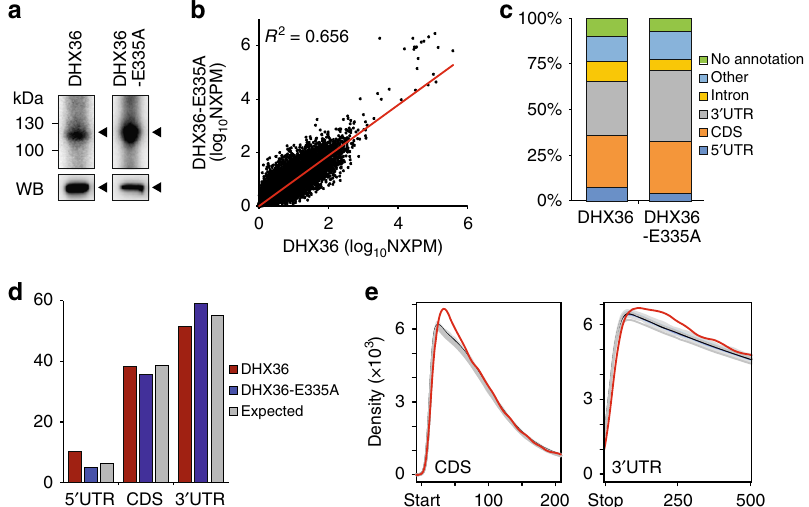
Fig. 2 DHX36 interacts with mature mRNAs at thousands of sites. a Autoradiographs of crosslinked and radiolabelled FH-DHX36 and FH-DHX36-E335A RNPs separated by SDS-PAGE (black arrowheads). HA, immunoblot for haemagglutinin tag. Source data are provided as a Source Data fi le. b Scatterplot of normalized crosslinked reads per million (NXPM) from FH-DHX36 and FH-DHX36-E335A PAR-CLIP experiments reveals high degree of correlation of high-con fi dence binding sites. Correlation coef fi cient ( R 2 ) is indicated. c Distribution of PAR-CLIP-derived binding sites from the intersection of two biological replicates across different RNA annotation categories. d The distribution of FH-DHX36 (red) and FH-DHX36-E335A (blue) binding sites across CDS, 3 ′ , and 5 ′ UTRs matches the distribution expected based on the length of the annotation categories (gray). e Metagene analysis of the distribution of DHX36 binding clusters 200 nt downstream of the start codon and 500 nt downstream of the stop codon, respectively (red). The distribution of 1000 mismatched randomized controls is shown in gray. The black line indicates the mean of the gray excellent correlation, with an R 2 of 0.79 and 0.93 for the FH- transformed them into small RNA cDNA libraries for next- generation sequencing. Using the PARalyzer software 31 , we DHX36 and FH-DHX36-E335A PAR-CLIPs, respectively (Sup- plementary Fig. 2a, b) and allowed us to de fi ne a set of determined clusters of overlapping reads that harbor character- reproducible high-con fi dence binding sites of 19,585 and 67,660 istic T-to-C conversions diagnostic of 4SU-crosslinking events at clusters, respectively (Supplementary data 2). The binding pro fi les higher frequencies than expected by chance (see Supplementary of FH-DHX36 and FH-DHX36-E335A were also highly data 1 for summary statistics). The biological replicates showed